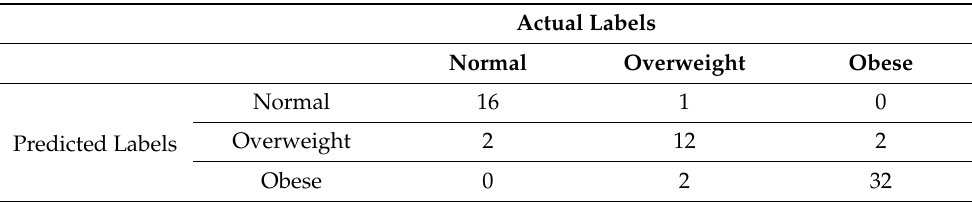
Figure 15. Feature importance of random forest for multiple random visits (unbalanced data). Table 11. Confusion matrix for random forest implementation for determining obesity category based on multiple random well-child visits (unbalanced